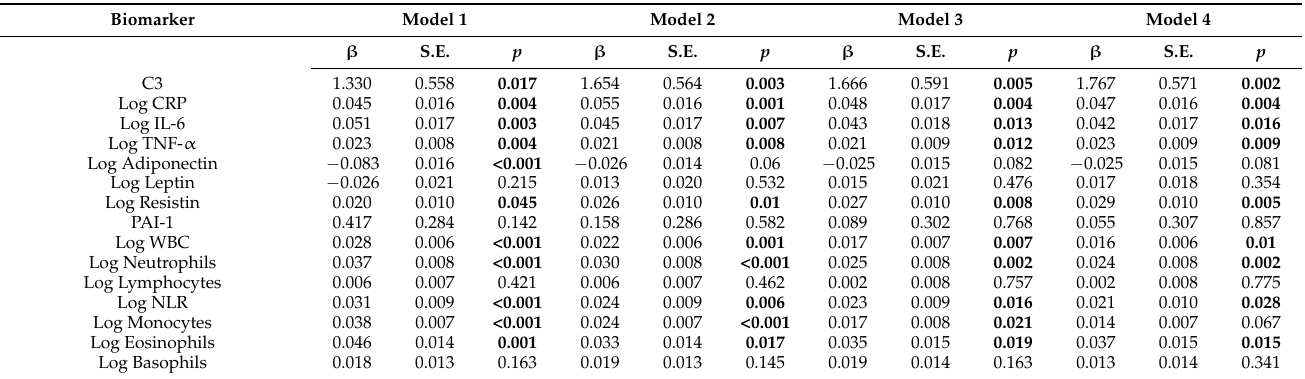
Table 4. Linear regression analysis of the associations between the FSAm-NPS dietary index and inflammatory and thrombotic biomarkers (n =